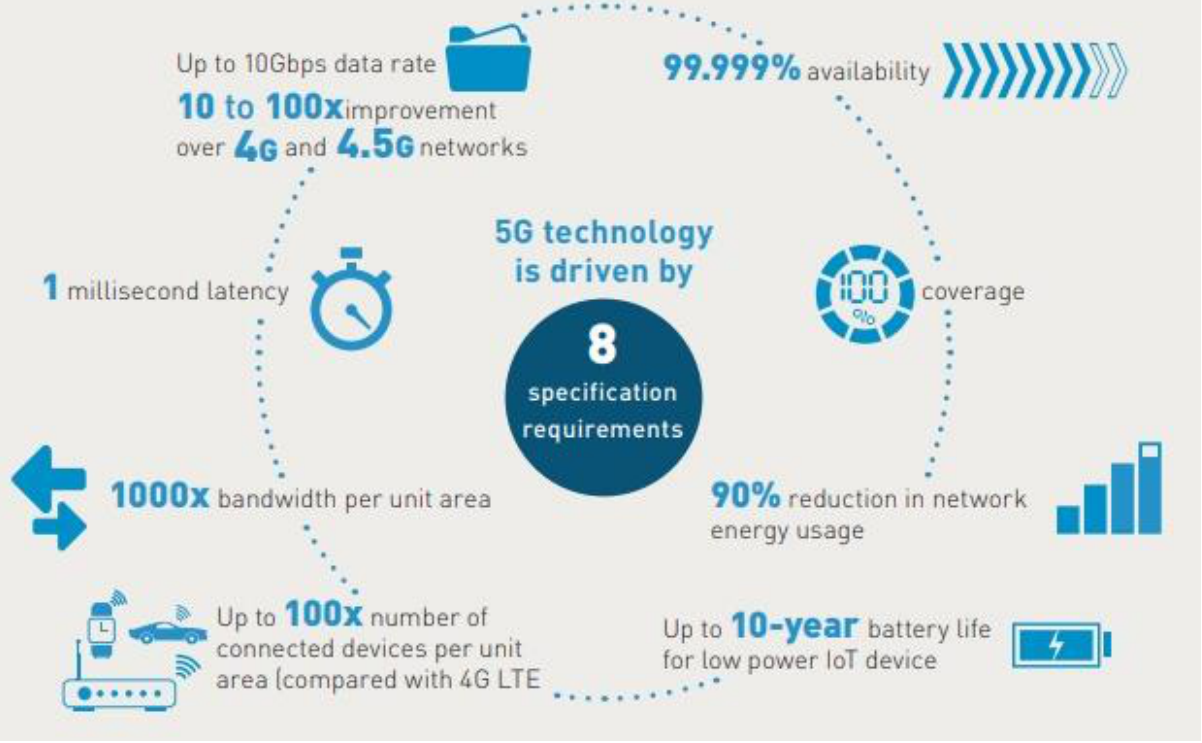
Figure 3. Eight specification requirements of 5G & beyond Technology.